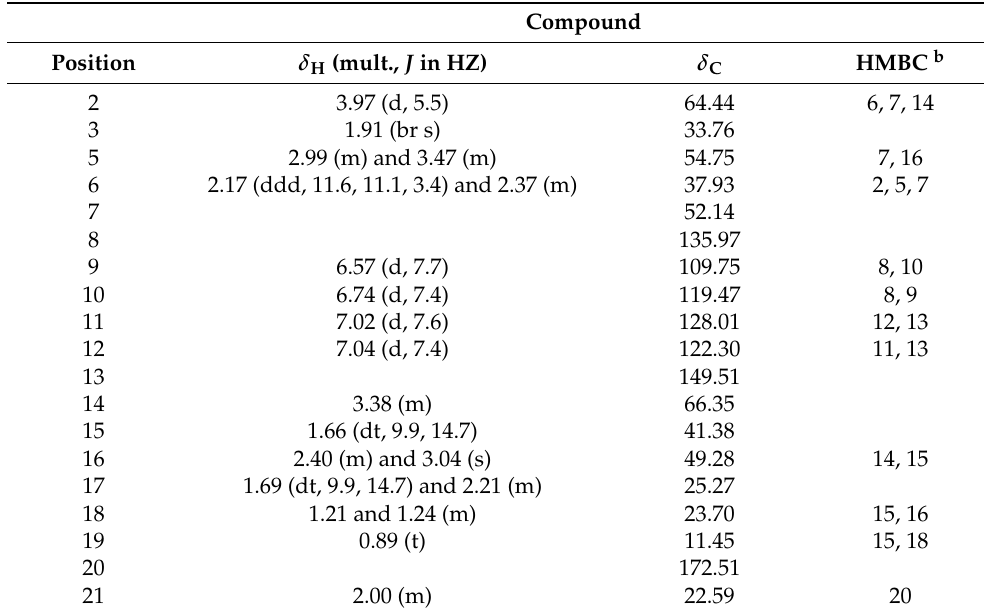
Table 1. NMR data and HMBC correlations for geissospermiculatine ( δ in ppm) a .